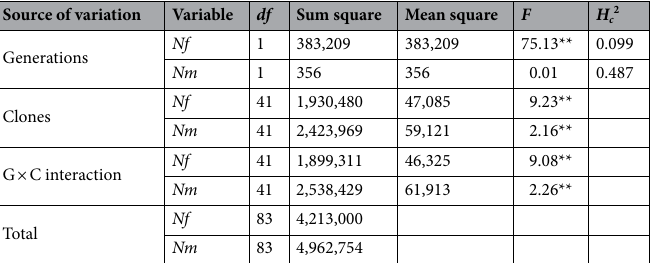
Table 1. Analysis of variance for female ( Nf ) and male ( Nm ) strobili production in seed orchards of Chinese fir. ** indicates significant difference at the level of 0.01, the same as below.